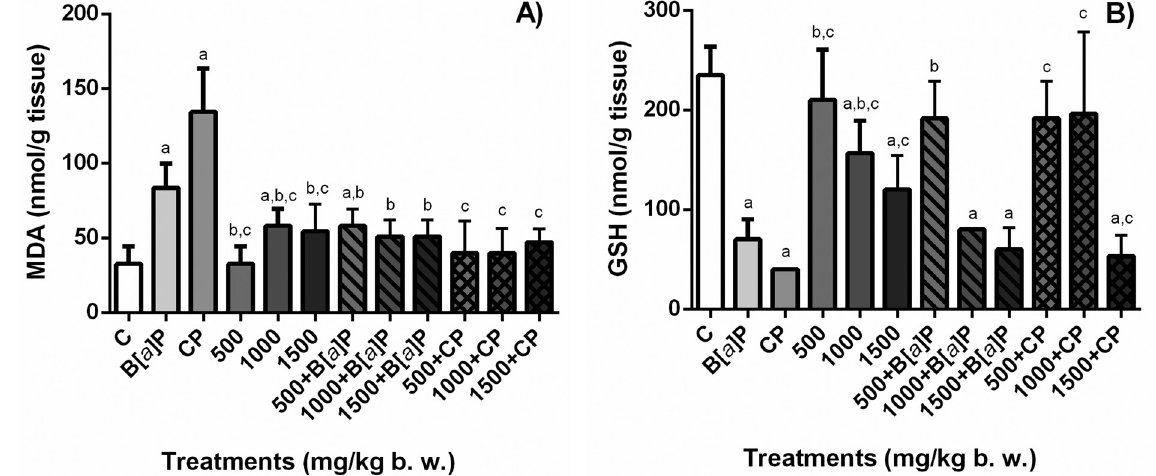
Figure 7 - Quantification of lipoperoxidation by measuring the formation of MDA, principal thiobarbituric acid-reactive specie (TBARS) (A) and GSH (B) in the kidney of mouse treated with S. dulcis bark ethanolic extract (500, 1000, and 1500 mg/kg bw) associated or not to the positive controls (B[ a ]P andCP).Resultsareshownasmeans±SD. a Statisticallydifferentfromnegativecontrolgroup; b statisticallydifferentfromB[a]Pcontrolgroup; c statisti- cally different from CPA control group. MDA: malondialdehyde; GSH: glutathione; C: distilled water; B[ a ]P: benzo[ a ]pyrene; CP: cyclophosphamide. Statistical analysis performed using ANOVA and Tukey’s test with significance threshold of p